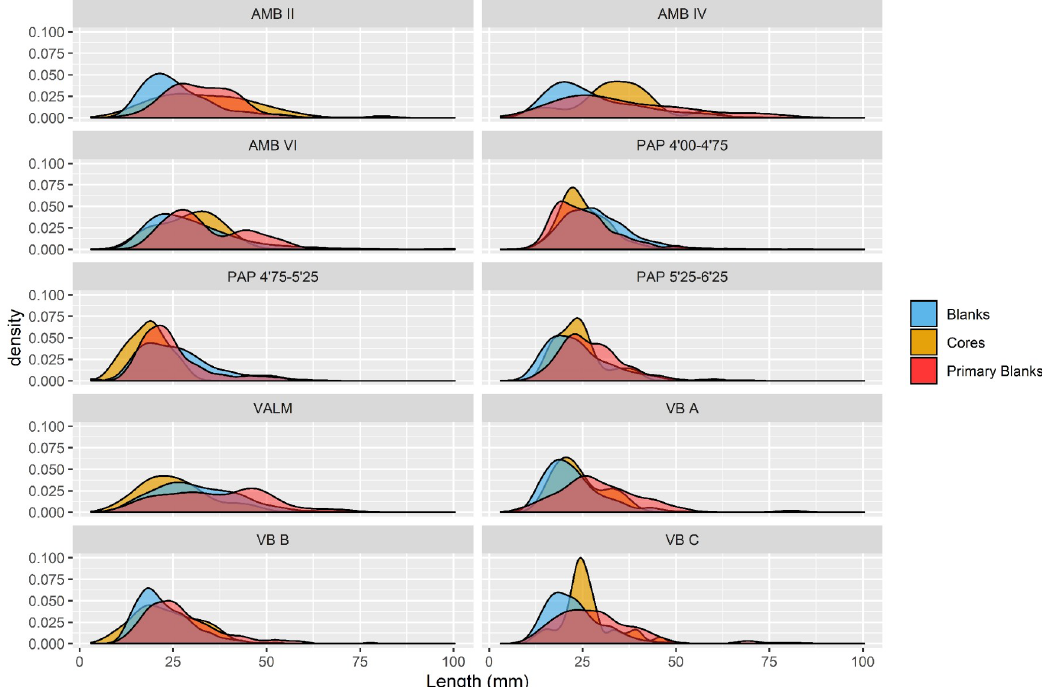
Fig 3. Density plots comparing the lengths of dominant blank scars on cores, blanks and fully cortical (primary) blanks. Following Henry [109] the plots show the relative flaking intensity for each assemblage.